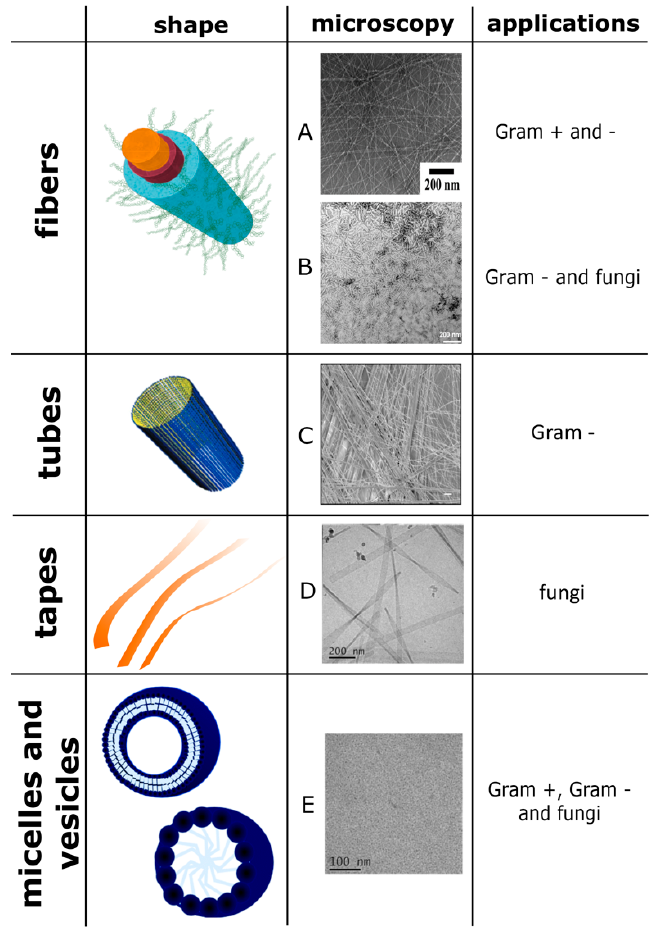
Figure 2. Some of the structures with antimicrobial properties mentioned in the article and their respective shapes assumed after the self-aggregation and their applications on pathogens. The image A is reprinted (adapted) with permission from reference [92]. Copyright 2014 American Chemical Society. The image B and the image of the fiber are reprinted (adapted) with permission from reference [111], scale bar is 200 nm. Copyright 2019 American Chemical Society. The image C is reprinted (adapted) from reference [94], scale bar is 10 µ m. This article is licensed under a Creative Commons Attribution 4.0 International License http://creativecommons.org/licenses/by/4.0/. The images D and E are reproduced from reference [104]—Published by The Royal Society of Chemistry. The images of the tube are reprinted (adapted) with permission from reference [112] Copyright 2009 American Chemical Society. The images of micelle and vesicle are reproduced from reference [42] published in 2017 by The Royal Society of Chemistry.